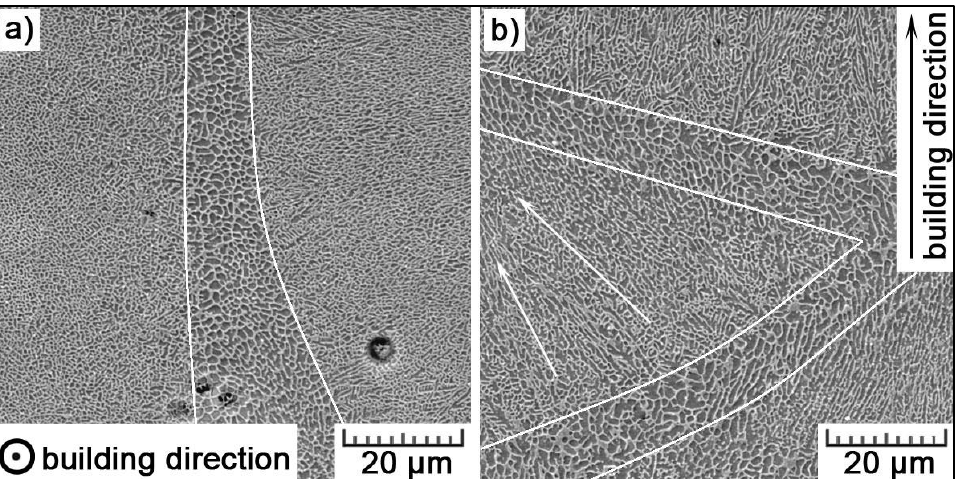
Figure 5. Fine cellular substructure in ( a ) transversal and ( b ) longitudinal section.